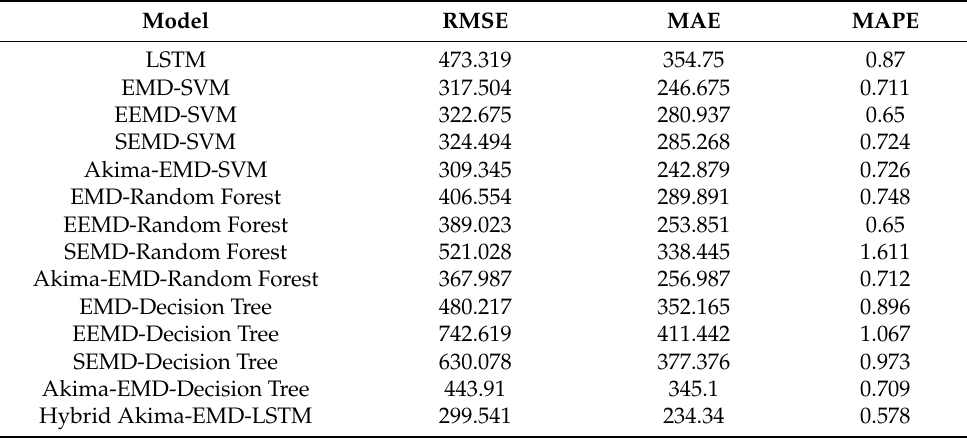
Table 12. Performance metrics of different hybrid